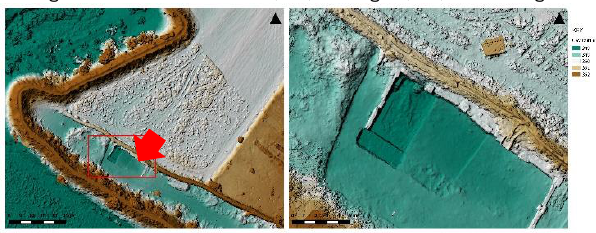
Figure 7. Oriented images showing 2 different flight planning strategies connected to the low (10m) and high (40m) altitude flights.